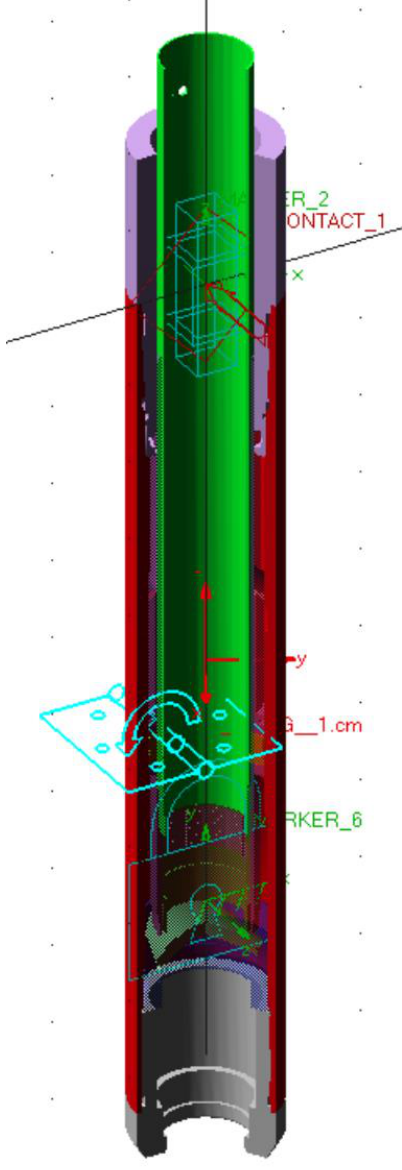
Figure 7. Mechanism model of trigger mechanism under ADAMS/View.